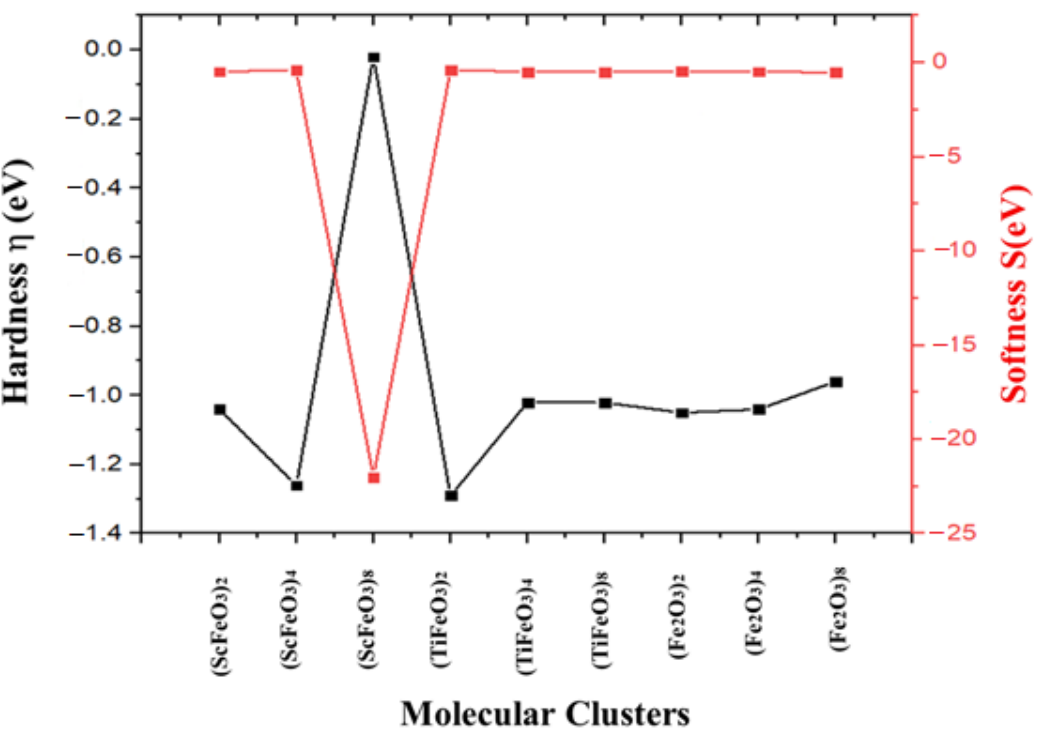
Figure 5. The computed values of softness and hardness for (TMFeO (cid:2871) ) (cid:2934) molecular clusters where x = 2, 4, 8 and TM = Sc, Ti, and Fe.